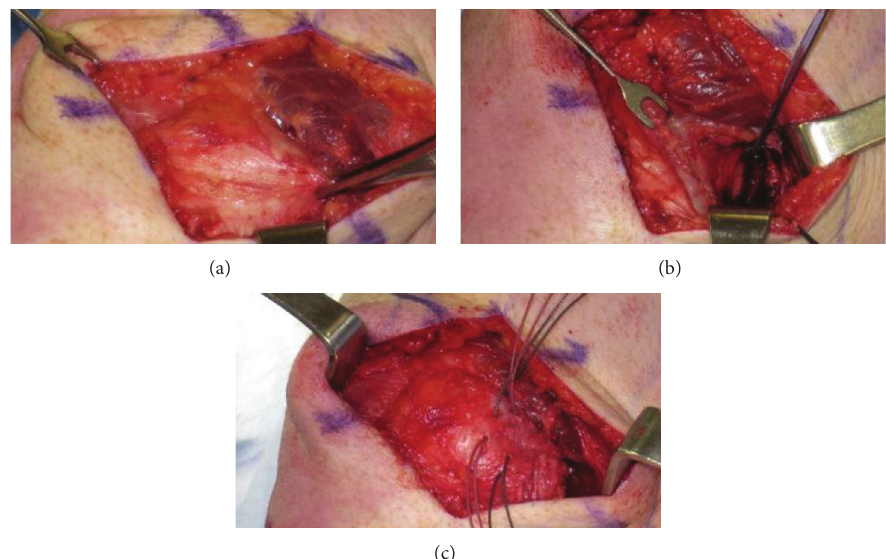
Figure 3: (a) The Allis clamp is being used to evaluate competency of the MPFL after it has been avulsed off the femur. (b) Suture anchors are placed at the MPFL insertion on the femur. (c) The MPFL is sutured back to the femoral insertion using suture anchors.